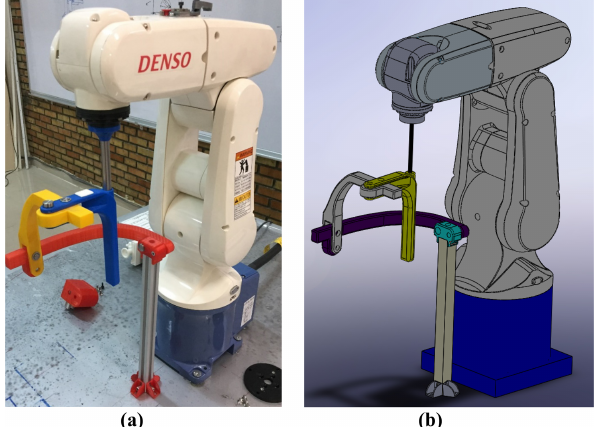
Figure 7. Exoskeleton driven by the Denso robot.